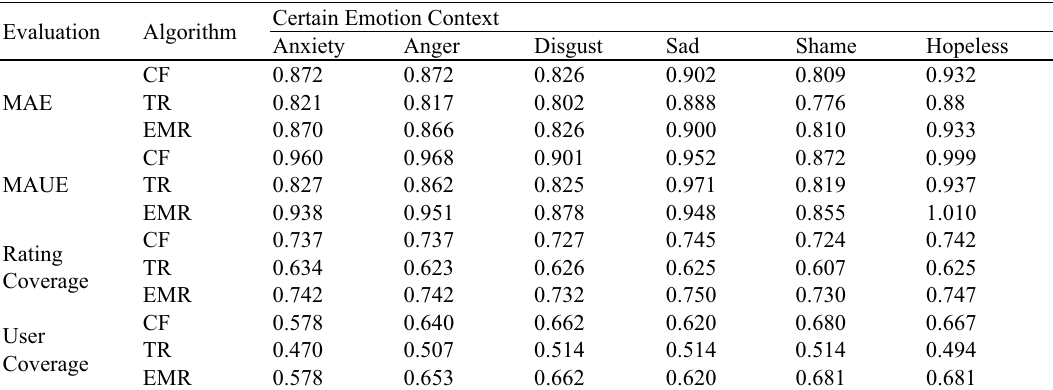
Table 8. The results of running CF, TR and EMR.